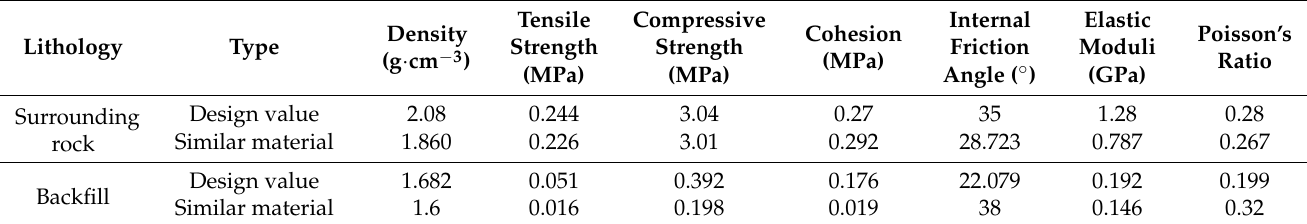
Table 3. Rock and backfill mechanical parameters in mining area No. 3 [16].